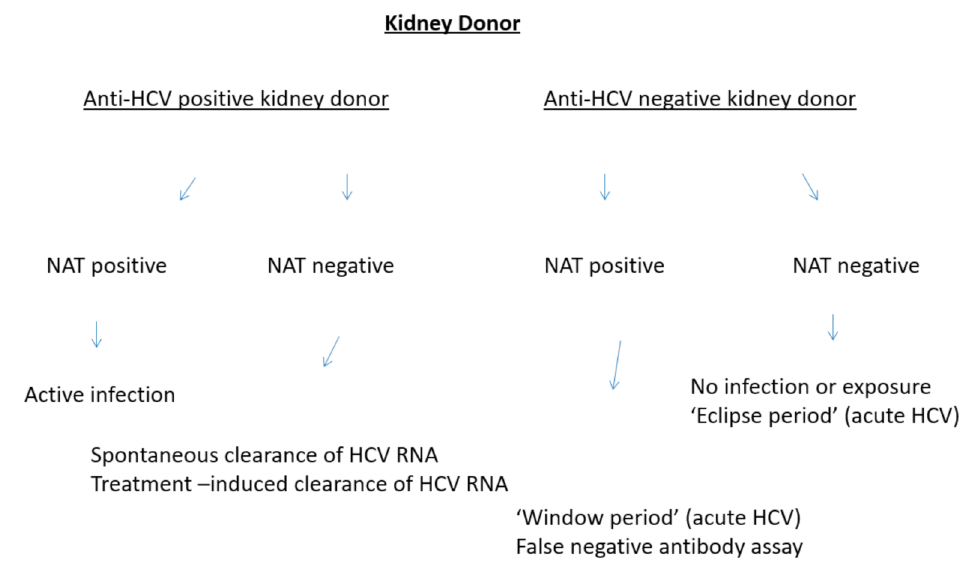
Figure 1. HCV diagnostic assays and kidney